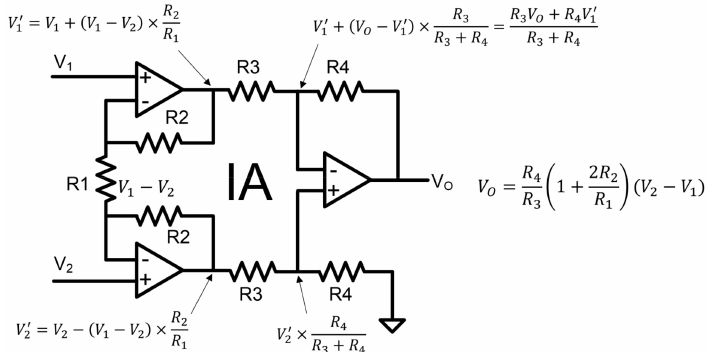
Figure 3. IA circuit diagram.